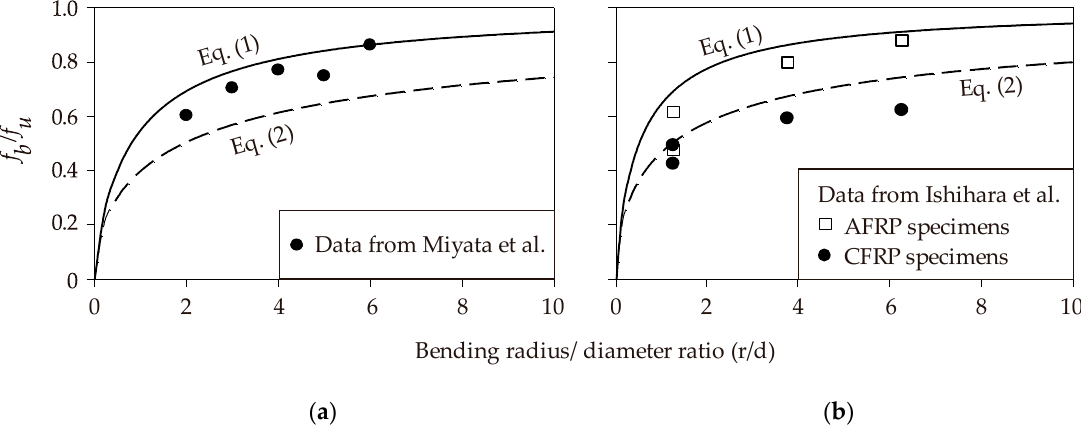
Figure 7. Predicted bend capacity of FRP bars from Nakamura and Higai’s ( a ) and Ishihara et al.’s ( b ) models.